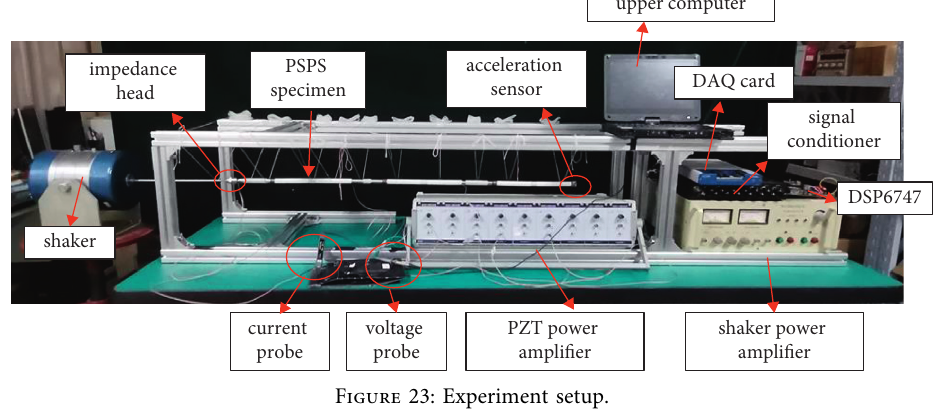
Figure 23: Experiment setup.